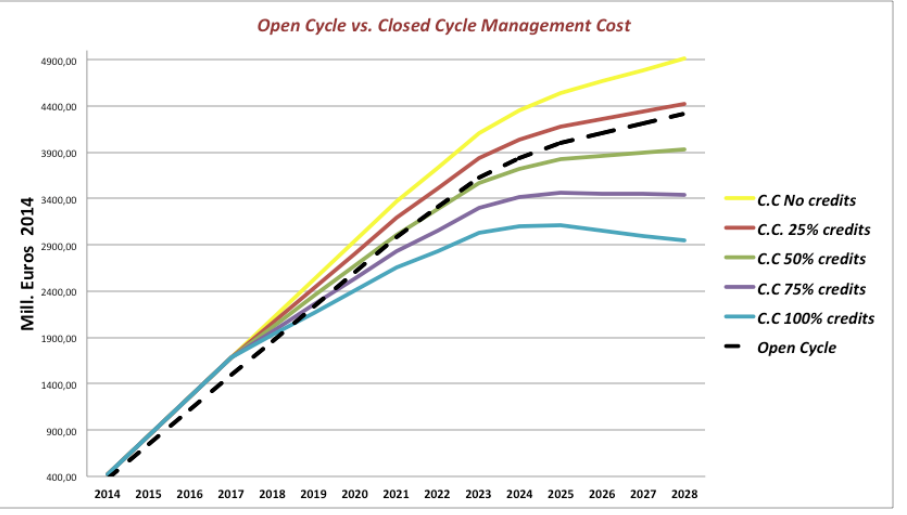
Figure 3. Comparative economic analysis of the management cost between open cycle and the different hypothesis of the closed cycle for all period of